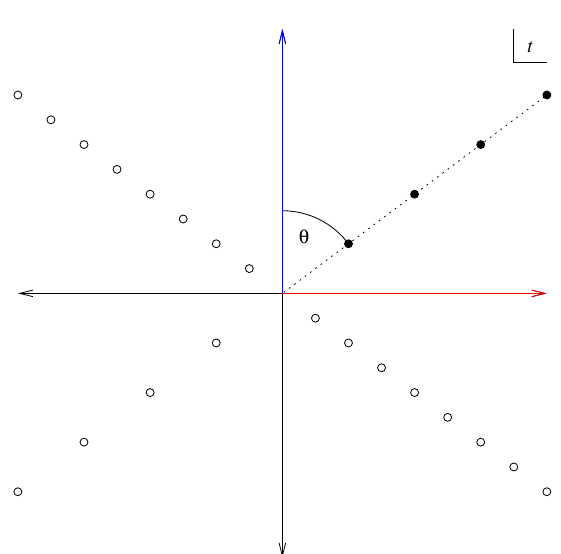
Figure 7. Poles in complex t plane for the integral expression (B.10). Integrating along the positive real axis gives log S ( x ) . Integrating along the positive imaginary axis gives log S II . The difference between the two is the sum over the residues of poles in the upper right